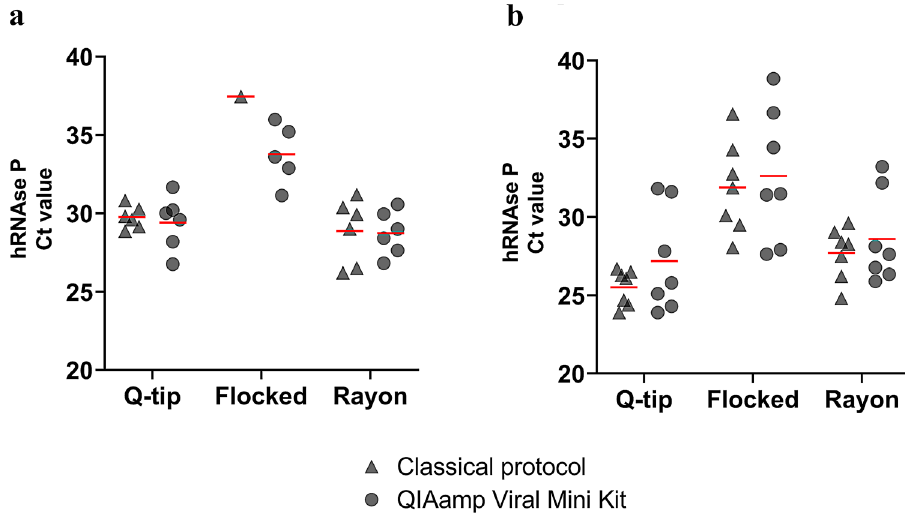
Figure 1. Comparison of swab types and RNA extraction methodologies for RNA extraction efficiency. Q-tips, flocked swabs, and rayon swabs were used, and RNA was extracted either by a classical protocol or the commercial kit. Ct values for hRNAse P amplification of oropharyngeal samples from ( a ) non-infected participants (n = 6); and ( b ) SARS-CoV-2-infected participants (n = 7). Means are represented by red